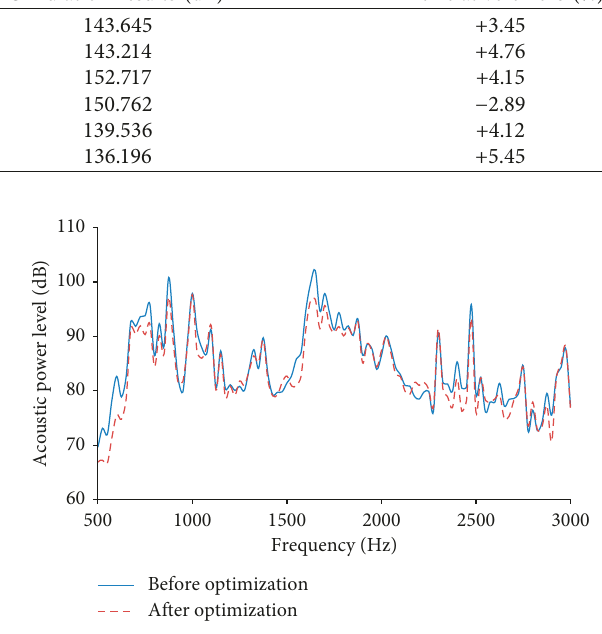
Figure 18: Acoustic power level before and after